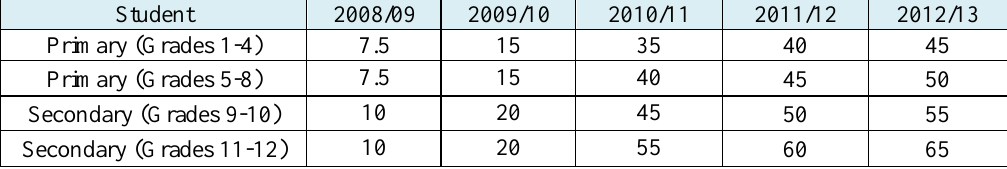
Table 5-7: Amount of GEQIP School Grant (ETB per student) (2008/09 -